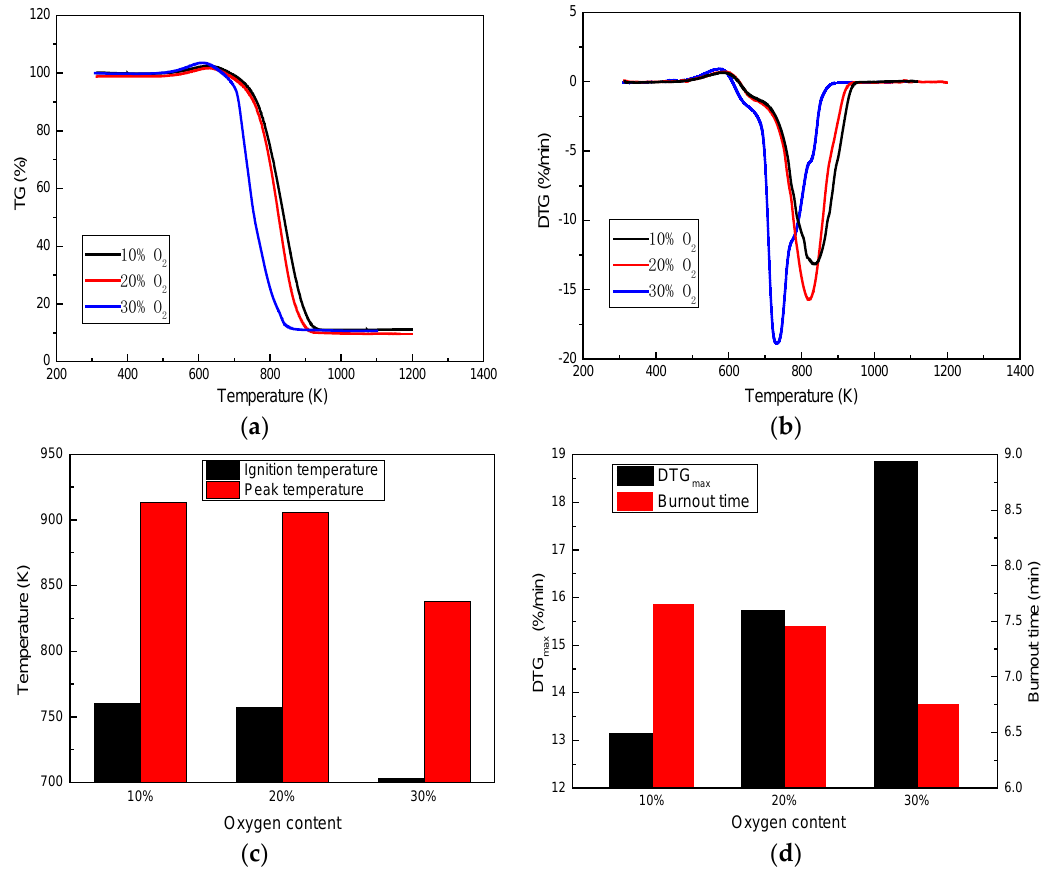
Figure 6. Effect of oxygen content on coal combustion: ( a ) TG profile; ( b ) DTG profile; ( c ) and ( d ) Coal combustion characteristics.